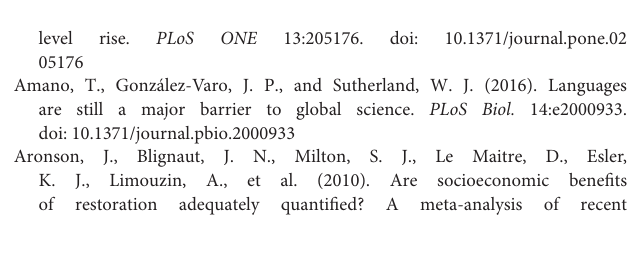
Supplementary Figure 1 | Number of papers assessing ecological outcome of coastal wetlands per year. Supplementary Figure 2 | Number of papers published per countries economy. Supplementary Figure 3 | Number of restoration sites per age